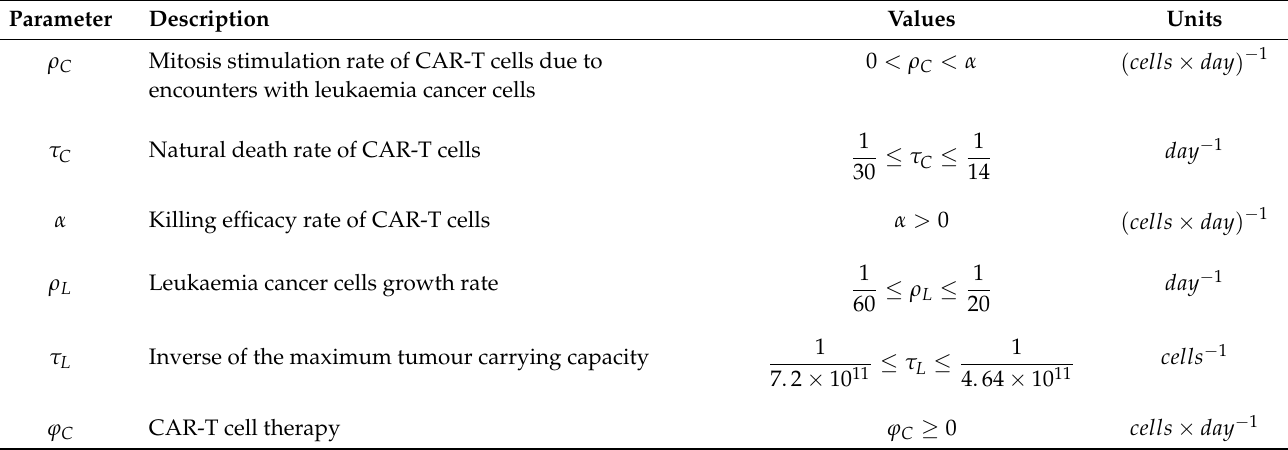
Table 1. Parameter information for the ALL and CAR-T cell therapy mathematical